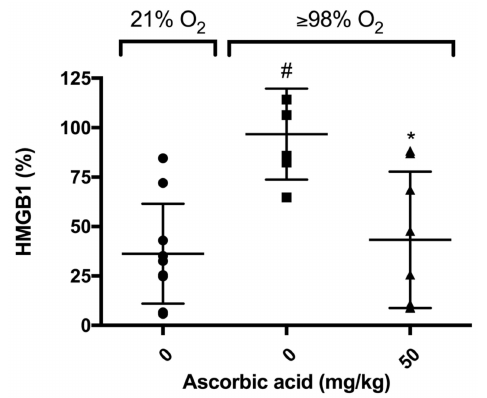
Figure 7. Ascorbic Acid (AA) attenuates hyperoxia-induced HMGB1 accumulation in the airways. Mice were exposed to ≥ 98% O 2 or 21% O 2 for 72 h and randomized to receive either ascorbic acid (50 mg / kg i.p. ) or saline. Animals were sacrificed and BALF was harvested and HMGB1 levels were determined. HMGB1 levels were analyzed using Western blot analysis. Each value represents the mean ± SEM of at least three independent experiments. * p ≤ 0.05 compared to 98% O 2 control mice. # p ≤ 0.05 compared to 21% O 2 control